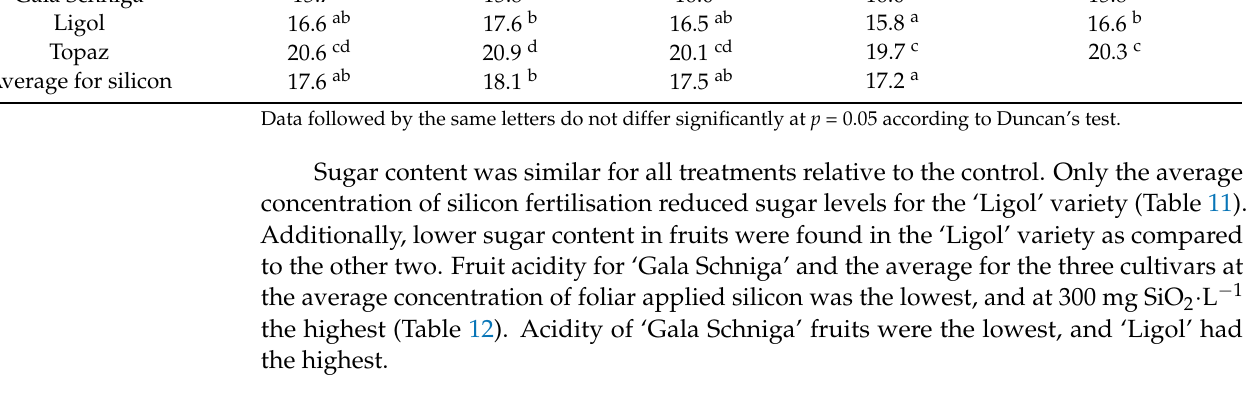
Table 11. The sugar content in fruits depend on cultivar and foliar silicon treatment ( ◦ Brix).